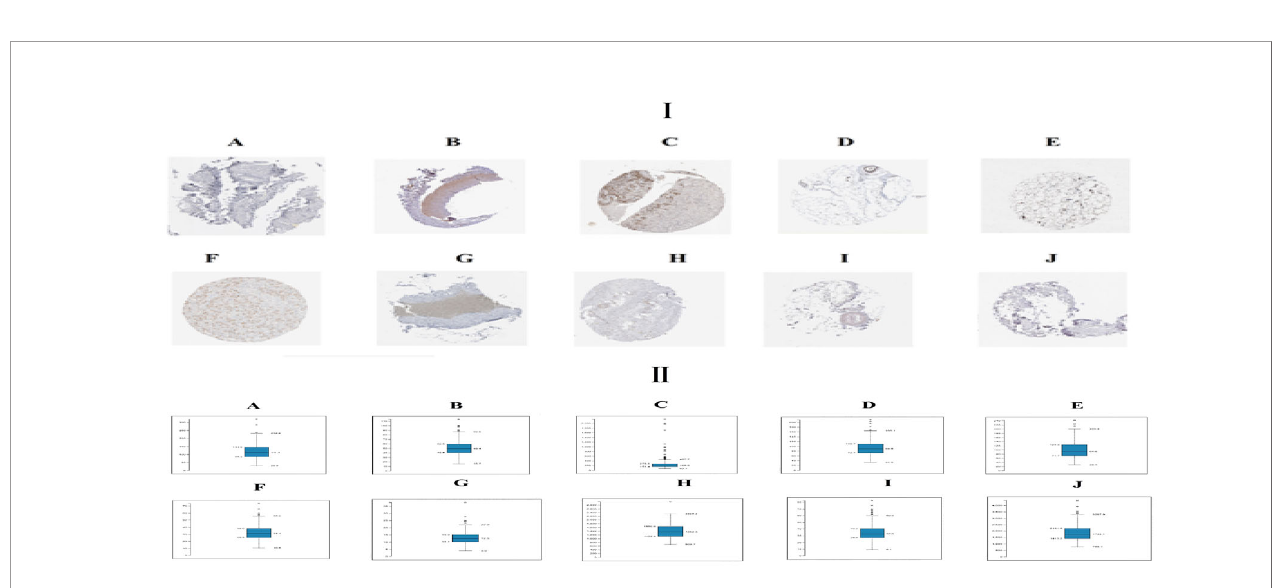
FIGURE 11 | I) Immunohisto chemical l (IHC) analyses of hub genes were produced using the human protein atlas (HPA) online platform. II) Box plot for IHC analysis of hub genes (A) STAT3 (B) CORO1C (C) SERPINH1 (D) MVP (E) ITGB5 (F) PCM1 (G) SIRT1 (H) EEF1G (I) PTEN (J)